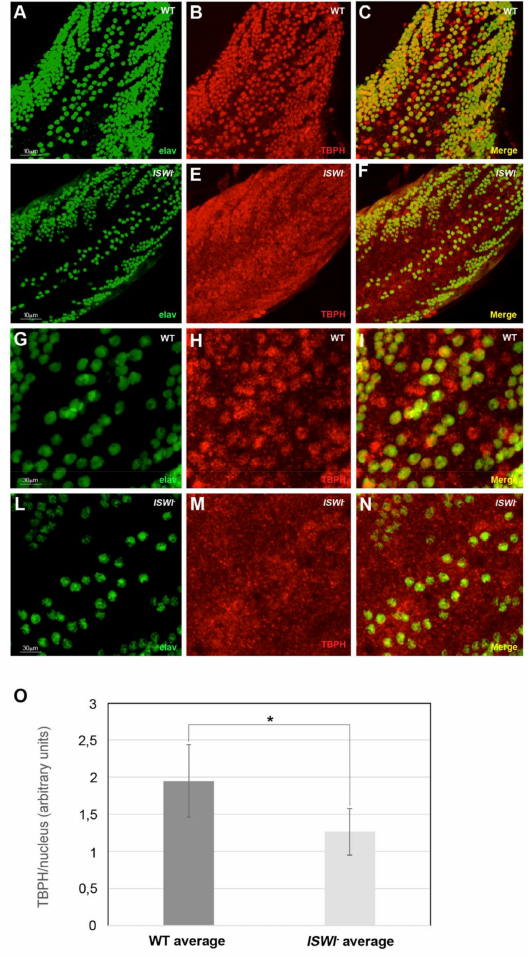
Figure 5. Changes in the distribution of TBPH hnRNP in ISWI null mutant compared to WT in the ventral ganglion of 3rd instar larvae. ( A – L ) Immunostaining on the ventral ganglia dorsal medial clusters of motoneuron nuclei in third instar wild-type ( A – C , G – I magnification) and ISWI - null mutant larvae ( D – F , L – N magnification). The mean intensity of TBPH (in red) in the motoneuron nuclei stained with neuronal nuclear protein anti-Elav (green) is significantly reduced in ISWI - null mutants ( F , N magnification) compared to wild-type ( C , I magnification), as visible also in the merge ( C , F ). ( O ) Quantification of the intensity of the immunofluorescence signals. The error bars show the standard deviation. Unpaired Student’s t -test was performed to assay statistical significance; * 0.01 ≤ p -value ≤ 0.05; ** p -value <